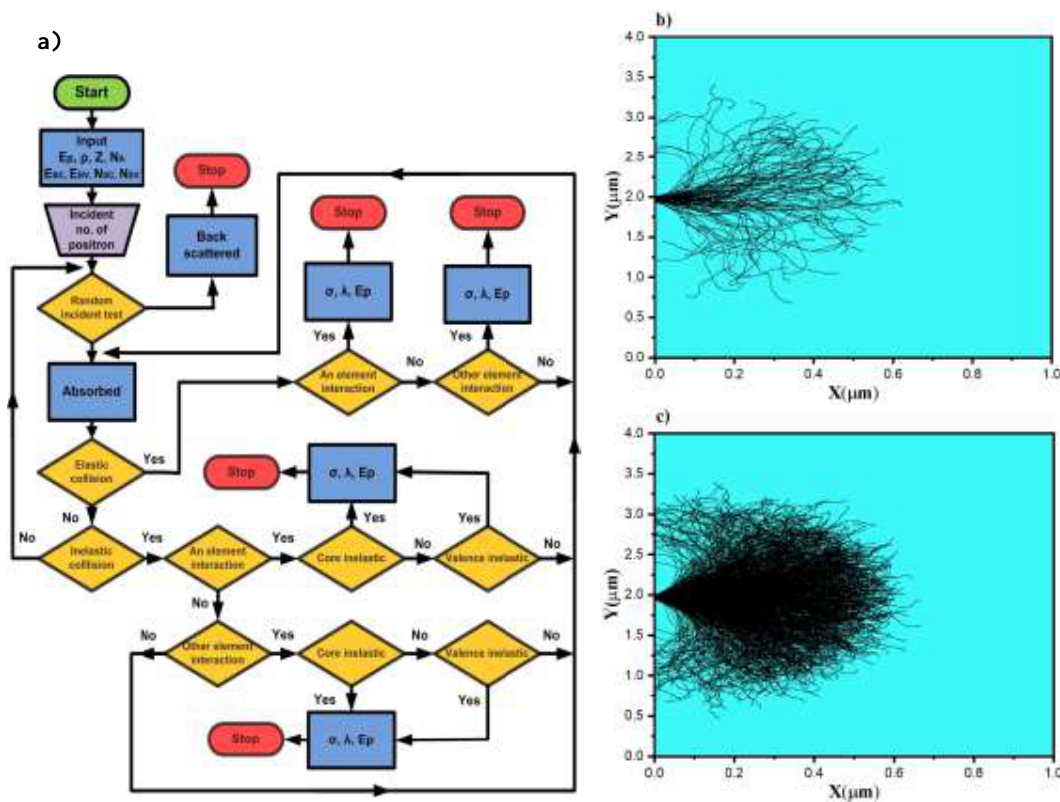
Figure 7: (a) Flow diagram of the modeling procedure: Backscattered and absorbed fractions of positrons, output, and feedback by Monte Carlo simulation for injection of (b) 100 particles and (c) 1000 particles for a liver organ, with 0.2 MeV particle